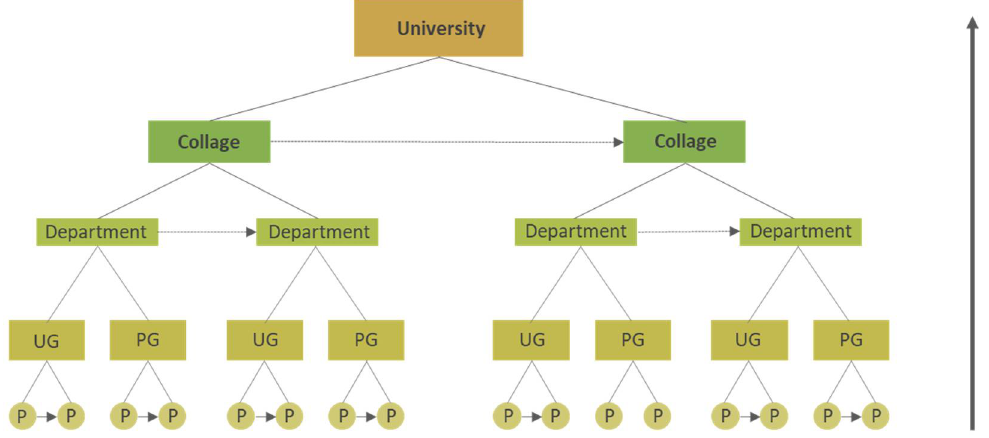
Figure 4. Bottom-up framework for KAU student capacity planning.